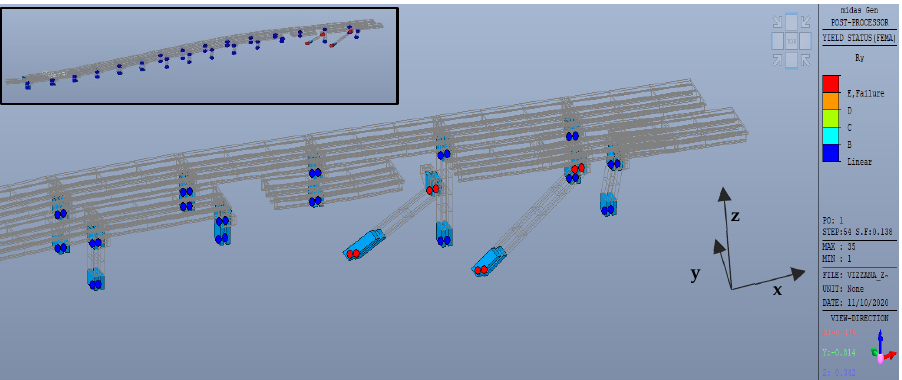
Figure 15. Example of displacement of northern piles 13 ( left ) and 14 ( right ) at step 54 for pushover curve n. 1 (main period).